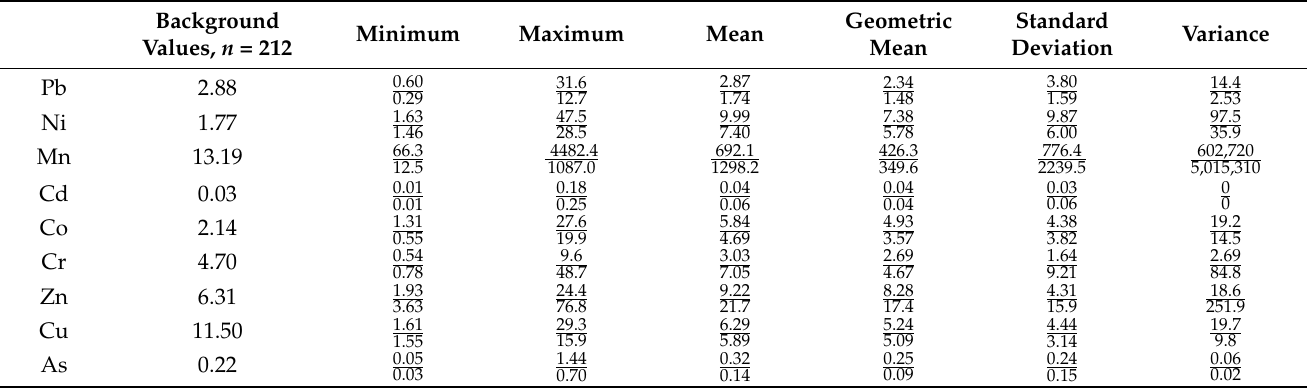
Table 4. Concentrations of mobile forms of metals and background values (mg/kg) in soil cover of the Nyurbinsky MPD in 2014 and 2018.